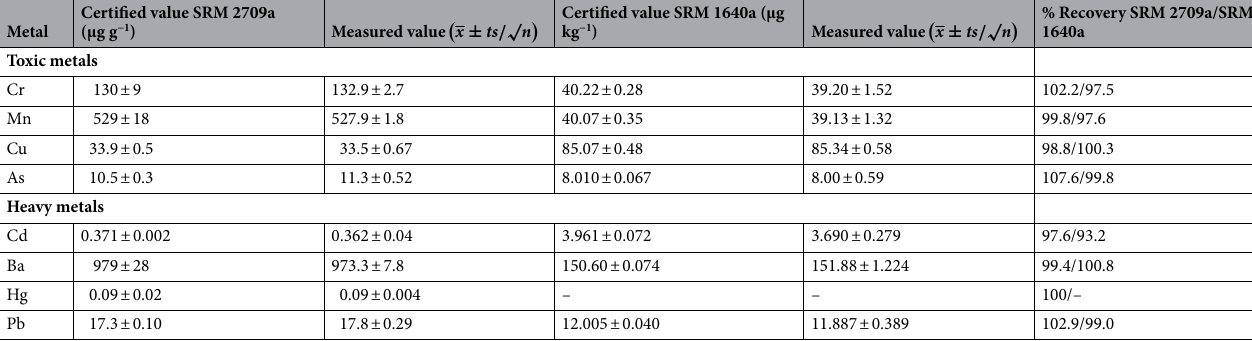
Table 3. Measured and certified values of the metals in SRM 2709a and SRM 1640a. ( x ± ts / ( p < 0.05, n = 6), CI = Confidence interval.